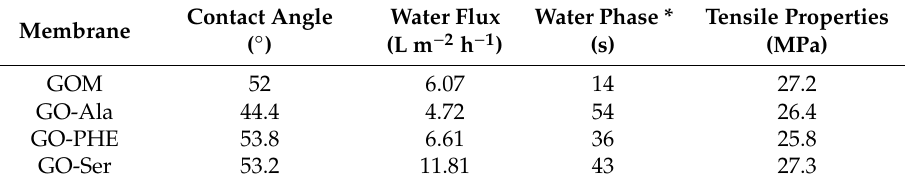
Table 1. Contact angle, water flux, stability, and tensile properties study of